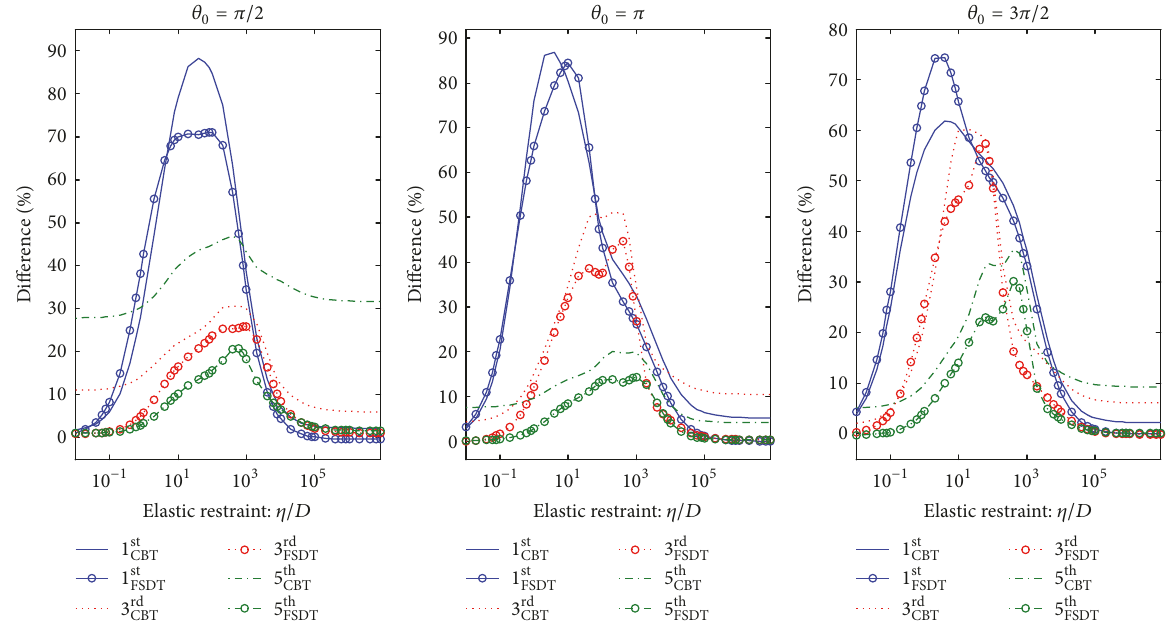
Figure 13: Relative deviations between frequency parameters Ω based on the CBT/FSDT theory models to those of 2D theory for elastically restrained circular beams with different restraint rigidities ( 𝜃 = 𝜃 0 : clamped; 𝜃 = 𝜃 1 : 𝑘 1 𝑢 = 𝑘 1 𝑤 = 𝜂